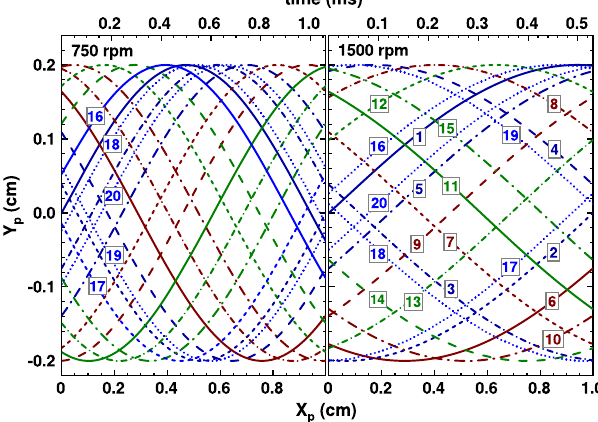
FIG. 12. Beam trajectories within the beam pulse correspond- ing to the 1-cm arc of the circle radius R c ¼ 12 cm, as calculated for the “ point ” beam ( σ b ¼ 0 ) and the 0.2 cm amplitude of beam FIG. 11. Normal beam-density distributions throughout the deflection produced by the wobbler on the target surface. The target surface in the direction perpendicular to the rotating calculations were done for the target velocities of 750 and direction, for σ b ¼ σ y ¼ 0 . 1 – 0 . 3 cm, resulting from simulations 1500 rpm, and 20 complete target wheel revolutions (the number (symbols connected by lines). Beam losses ε (in %) corre- of revolutions is indicated in squares). Thus obtained trajectories loss sponding to the beam cut by the 1 cm annulus width of the are shown by five different lines (from solid to dash-dotted ones) rotating target are indicated for the respective values of σ b . The of the same color. Trajectories obtained after 17 and 15 beam distributions are compared to the uniform distribution revolutions (shown by dotted lines) at the velocity of 750 and assumed in the time-dependent temperature calculations consid- 1500 rpm, respectively, are approaching those obtained for the ered in Sec. III A 1 (straight solid lines). previous target wheel